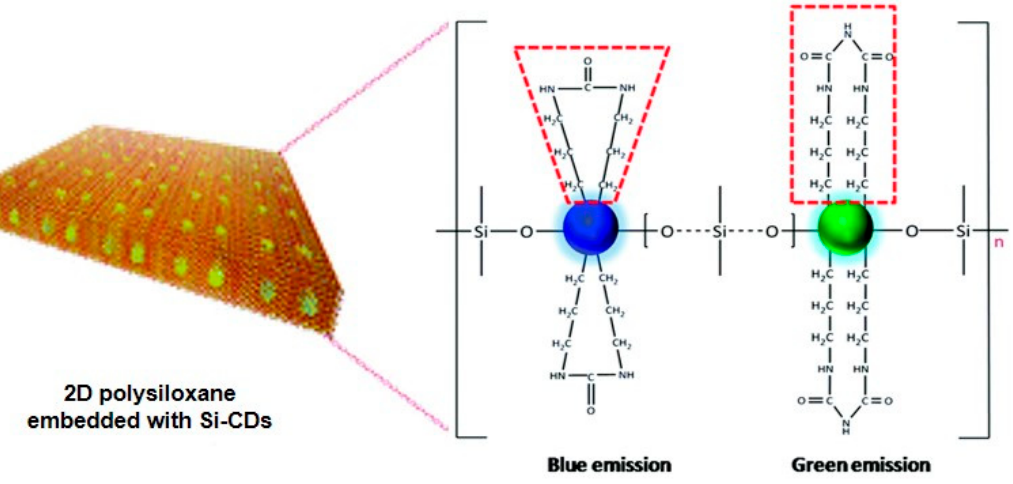
Figure 18. Schematic diagram of the 2D polysiloxane [102] . Copyright 2020, Royal Society of Chem- istry.